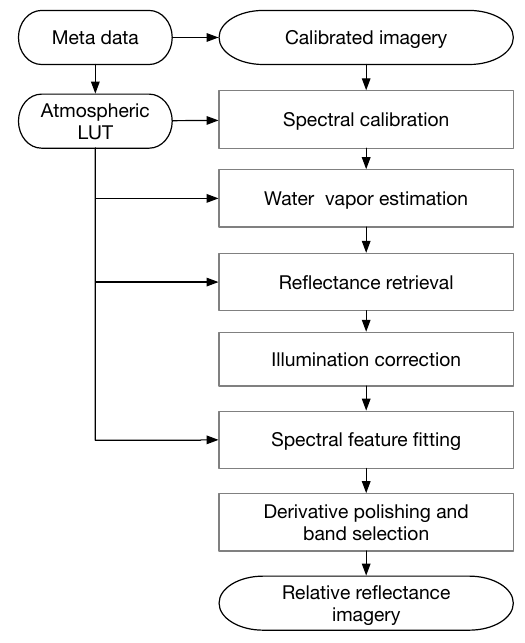
Figure 2. Process flowchart for DROACOR-H ground based horizontal reflectance